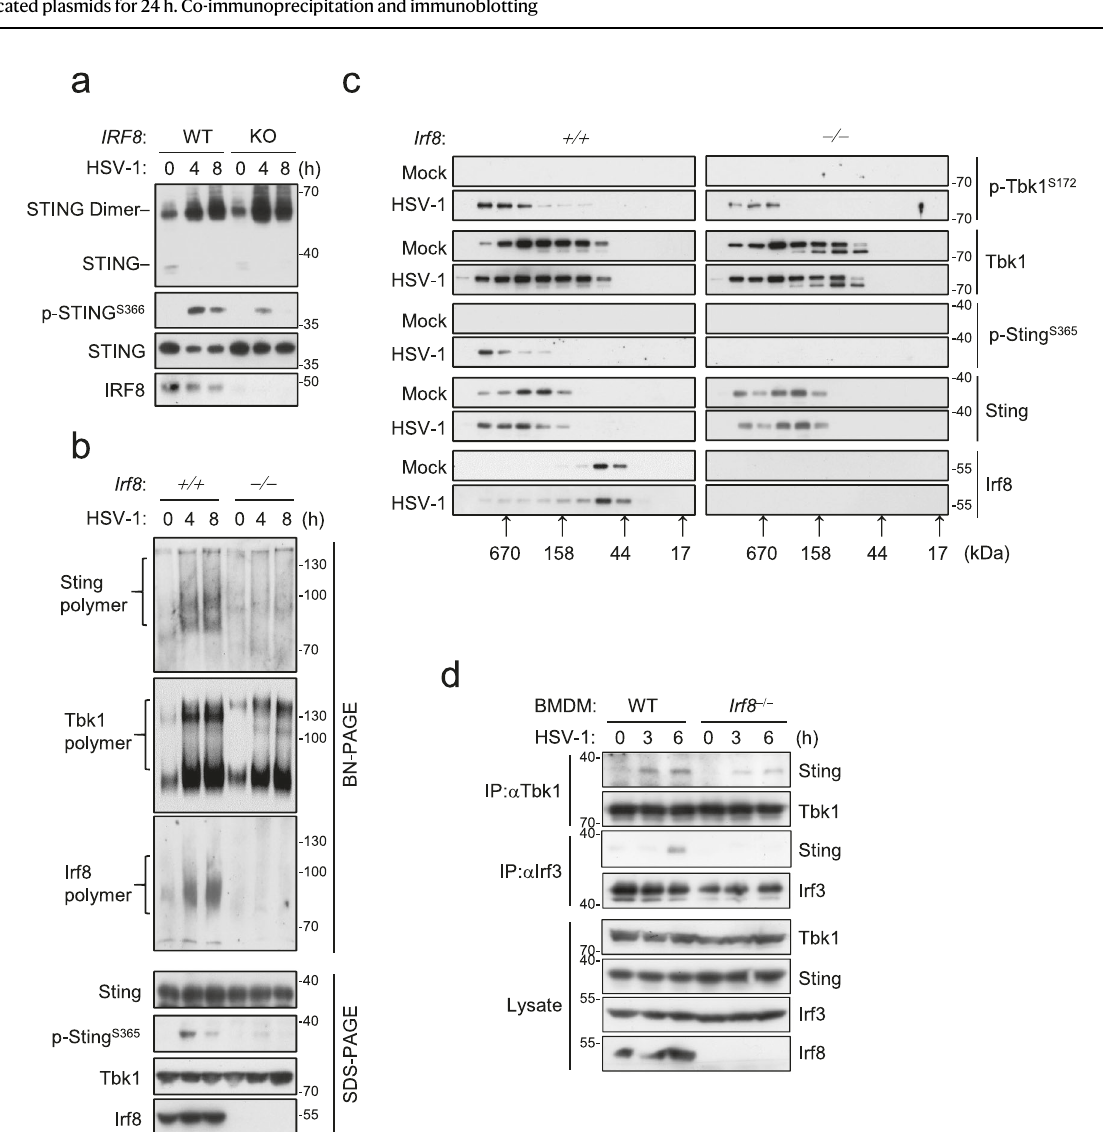
analysis were performed with the indicated antibodies. EV, empty vector. f Endogenous association of Irf8 and Sting in BMDM cells. The cells were left uninfectedorinfectedwithHSV-1fortheindicatedtimes.Co-immunoprecipitation and immunoblotting analysis were performed with the indicated antibodies. g Immunostaining analysis of IRF8 localization in HeLa transfected with IRF8-Flag (violet),STING-cherry (red)and the indicatedGFP-taggedmarker plasmids (green) for 24h and then un-stimulated or stimulated with 2 ′ 3 ′ -cGAMP for 4h. GFP- Rab9 (ER marker), GFP-p58 (ERGIC marker), and GFP-GM130 (Golgi marker). Scale bars, 10 μ m. h Immunostaining of p-Sting S365 (green) and Irf8 (red) in murine lung fi broblasts stably transduced with Irf8 and infected with HSV-1 for 6h or trans- fected with 2 ′ 3 ′ -cGAMP and HSV120 for 4h. Scale bars, 20 μ m. Source data are provided as a Source data fi le.